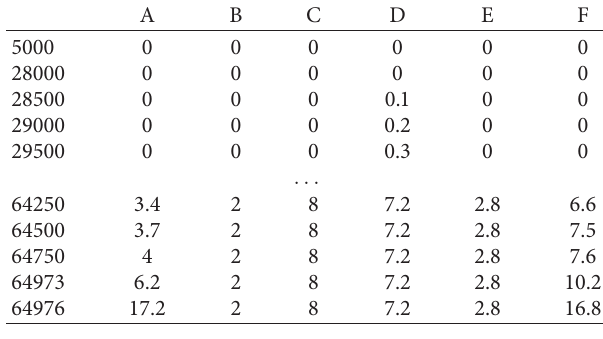
Table 7: Partial test data of constant amplitude three-hole test